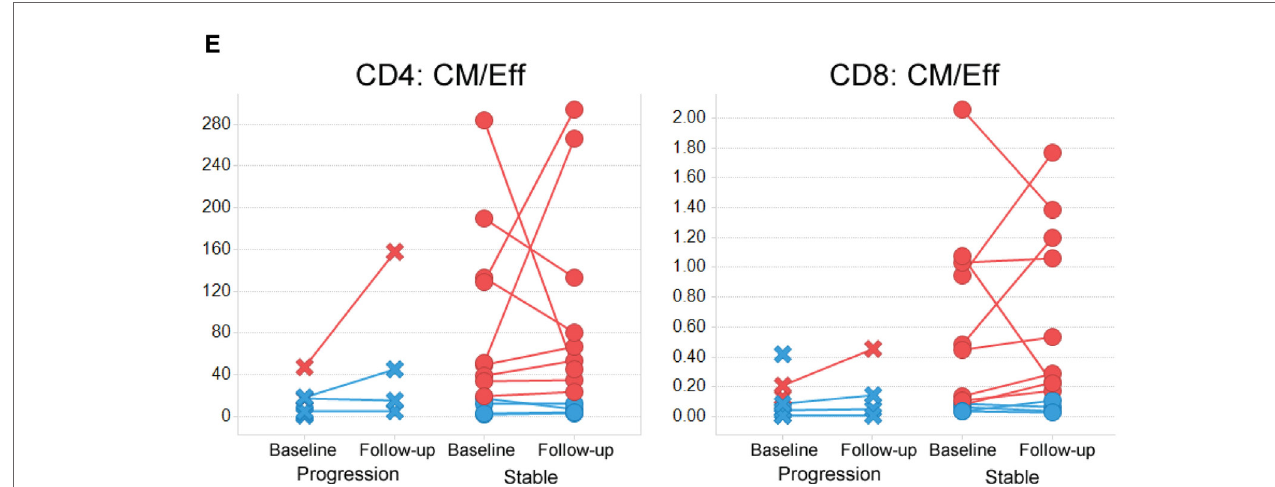
FigUre 3 | High central memory (CM)/effector (Eff) T cell ratios at baseline are associated with longer progression-free survival (PFS) in response to nivolumab treatment for NSCLC. (a) Peripheral T cell profiles in a second cohort of NSCLC and control samples (Bonferroni-corrected p -values: * < 0.001, ** < 0.0001, line marks the median for subpopulation). (b) Distribution of PDL1 tumor proportion score (TPS) ( n = 23, the horizontal line marks the cutoff at the antimode: 25% TPS). (c) CM/Eff T cell ratios in the NSCLC cohort coded by PDL1 TPS (open circles: PDL1 expression not evaluated). CM/Eff T cell ratios high vs. low division line is drawn using the 90th percentile of the control samples. Fischer’s p -value < 0.025. (D) PFS after nivolumab treatment ( n = 22) ( p -value < 0.05, median survival by CM/Eff ratio: low, 91 days; high 215 days). (e) Change in CM/Eff T cell ratios three months after nivolumab-treatment initiation. Patients are classified by physician- reported response to treatment at three